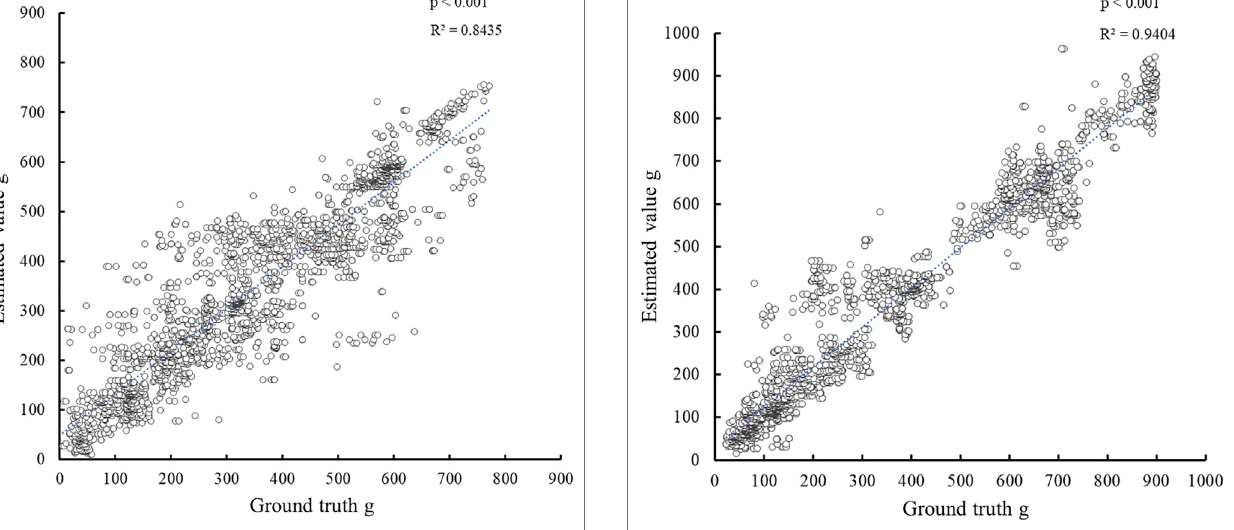
FIGURE 5 | Results of relationship between measured and estimated values of the force of the middle fi nger. The horizontal axis is the measured value acquired by the force sensor, and the vertical axis is the estimated value by FirstVR. p -value indicates the signi fi cant result of the correlation coef fi cient. The result shows a signi fi cant